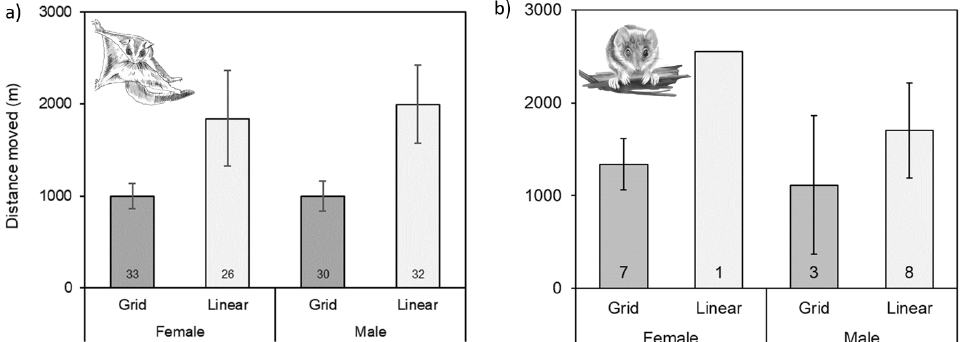
Figure 6. Mean distances moved ( ± standard error) between recaptures within patches of habitat (sampled in grids) and in linear strips (sampled as transects) for female and male ( a ) sugar gliders ( Petaurus breviceps ); and ( b ) brown antechinus ( Antechinus stuartii ). Individuals used in analysis were detected at two or more sites. Numbers below bars represent N sample size. Credit for illustration on left: Rocco Russo; and on right: Tracy MacVean.